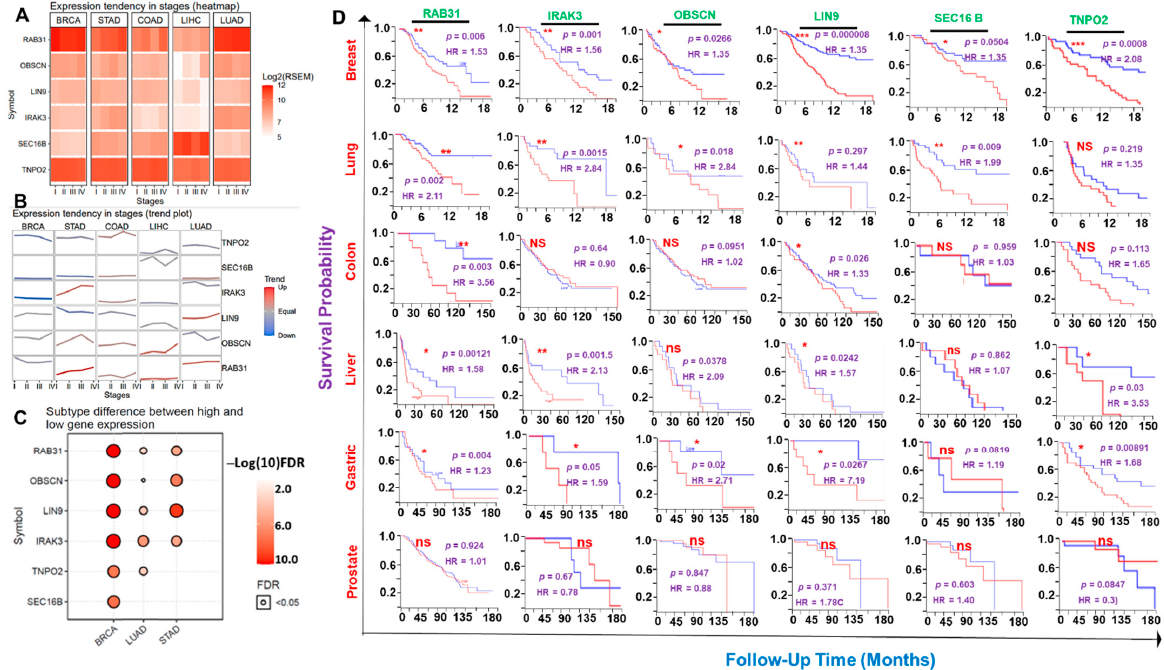
Figure 3. The cancer hub gene signatures are of clinical prognostic relevance. ( A ) Heatmap and ( B ) trend plot showing the differential expression levels of the hub genes between tumor stages across the six cancers. ( C ) Bubble plot showing significant differences in the expression levels of the hub genes in the molecular subtypes of the breast, lung, and stomach cancers. ( D ) Kaplan–Meir plot showing survival differences between hub cancers cohorts with high and low gene expression levels. * p < 0.05; ** p < 0.01; *** p < 0.001. HR: Hazard ratio, ns: non-significant.